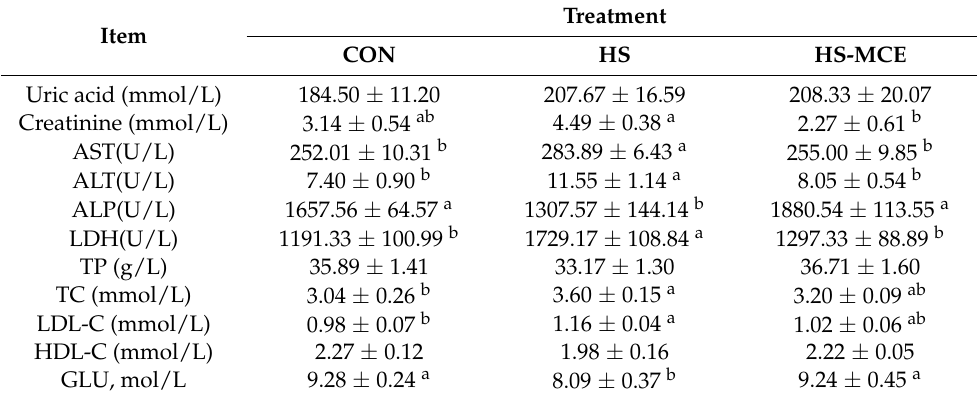
Table 4. Effects of HS and MCE on biochemical indices of yellow-feathered